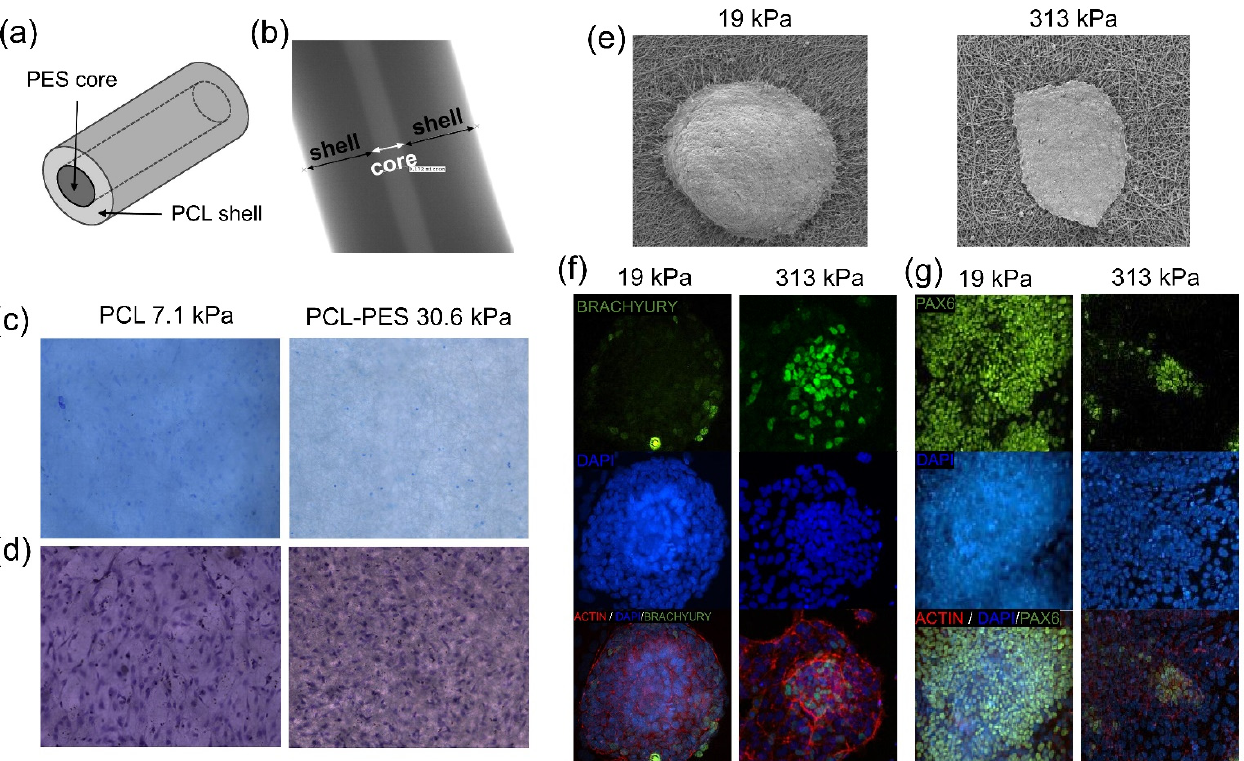
Figure 2. Modulation of stem cell differentiation via scaffold stiffness. ( a , b ) A schematic and a TEM image showing a core–shell PES-PCL electrospun nanofiber. ( c ) Alcian blue staining images showing greater chondrogenic differentiation of MSCs cultured on softer pure PCL (left) as compared to stiffer PCL-PES core–shell fibers (right). ( d ) Histological images showing greater alkaline phosphatase activity indicating enhanced osteogenic differentiation of MSCs cultured on stiffer PCL-PES core–shell nanofibers (right) as compared to softer pure PCL (left) [93]. ( e ) scaffold stiffness-dependent induced iPSC colony morphology on soft (left) and stiff (right) nanofibers. ( f , g ) Fluorescence images showing stiffness-dependent mesendodermal and ectodermal differentiation of iPSCs